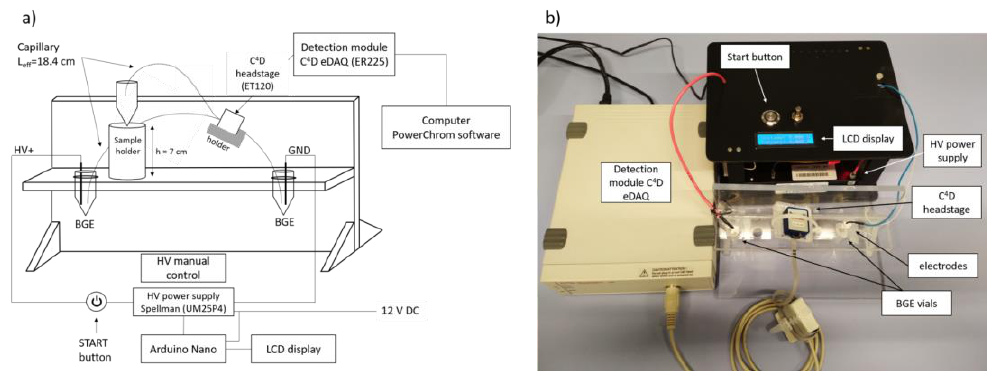
Figure 3. Scheme (a) and a photograph (b) of the CE-C 4 D in-house built instrument.